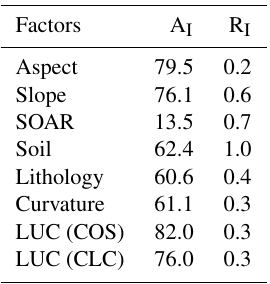
Table 4. Results of the accountability (A I ) and reliability (R I ) in-